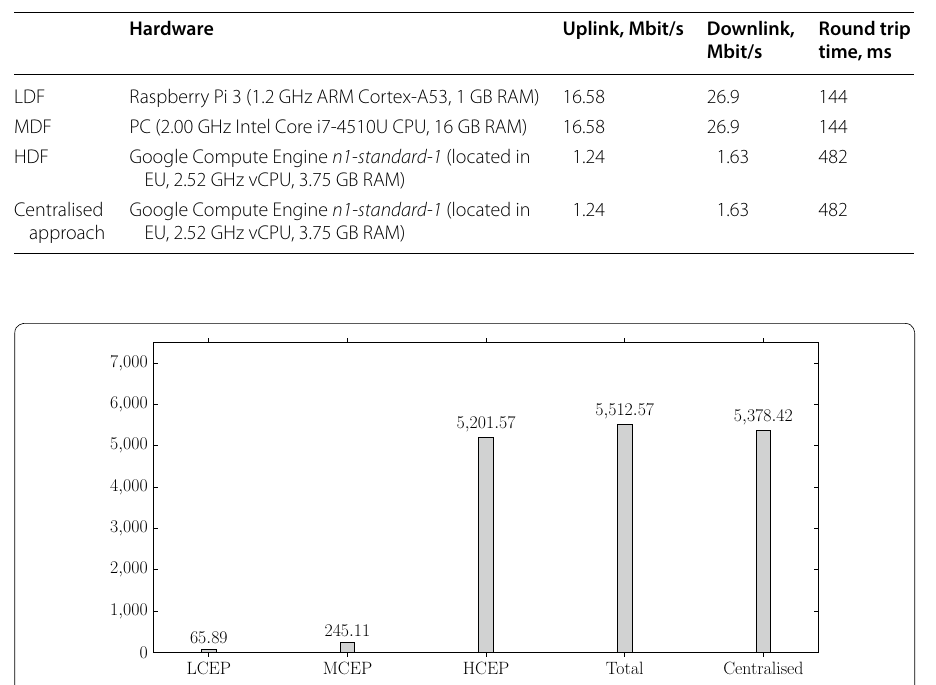
Fig. 5 Processing time benchmarking results, ms. This figure contains experimental results that demonstrate how much time is required at each level to process data and take a decision using the proposed approach,